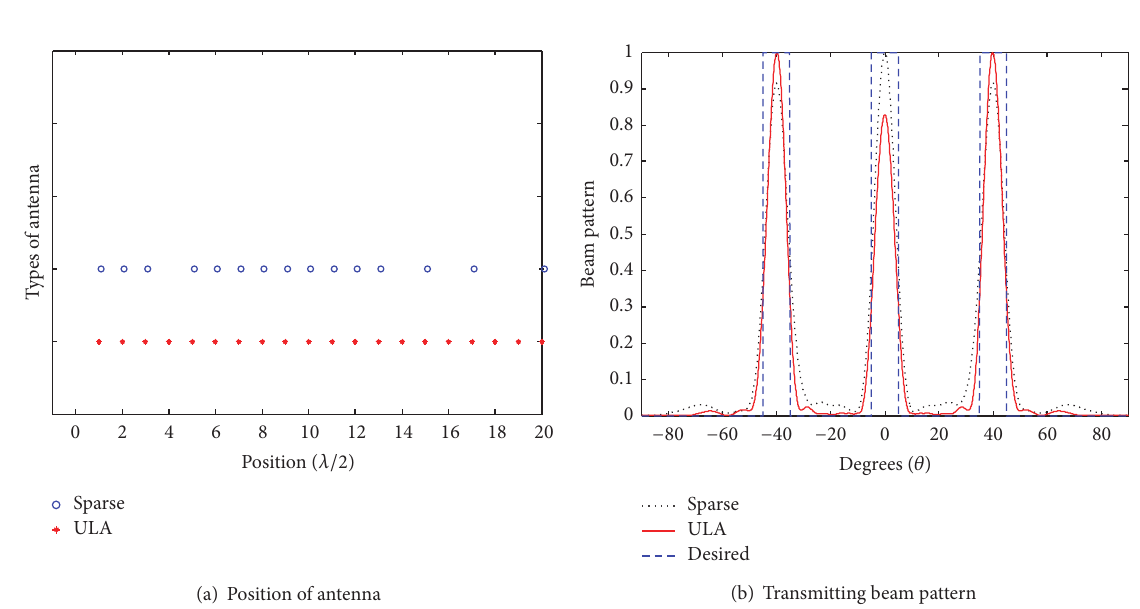
Figure 5: Results of DE with mutation strategy